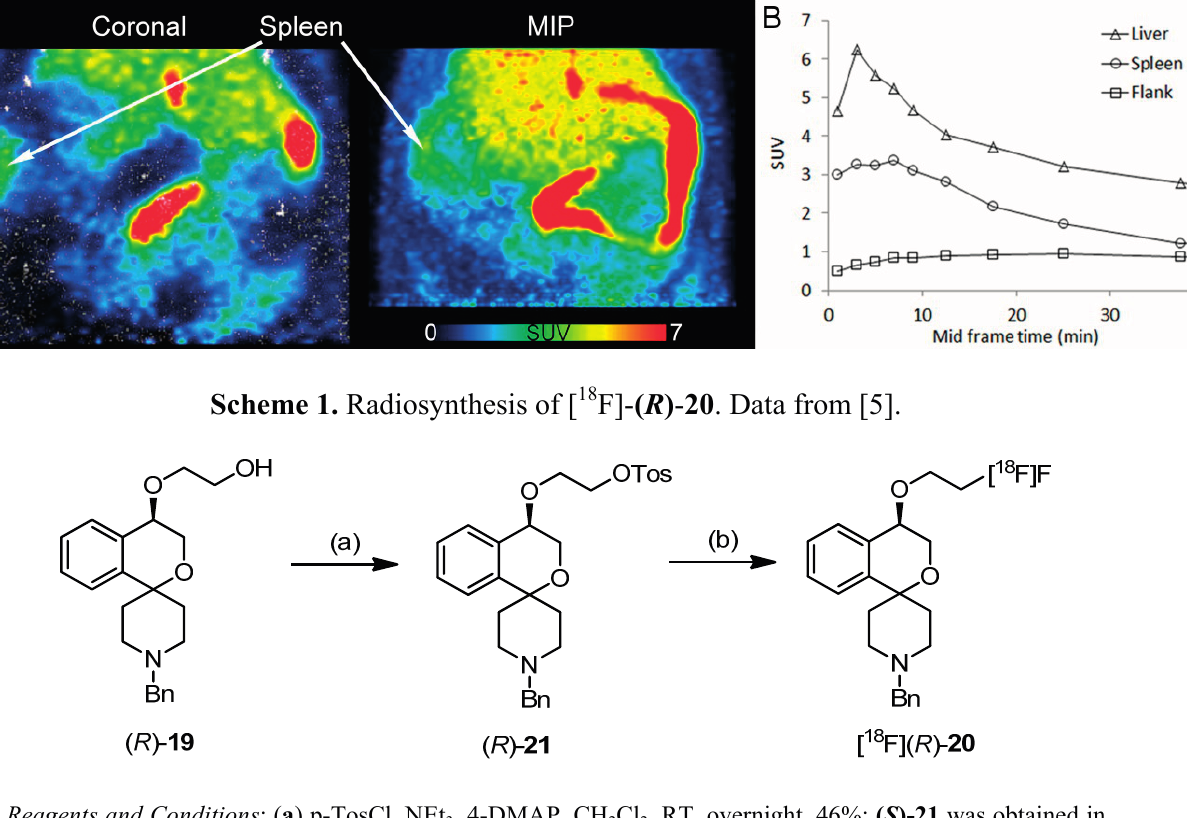
Figure 2. PET/CT images of [ 11 C]KP23 in the spleen-liver region in rat. ( A ) Coronal section and maximal intensity projection (MIP) averaged from 6 to 15 min p.i. ( B ) TACs of [ 11 C]KP23 in spleen, liver and flank. Data from